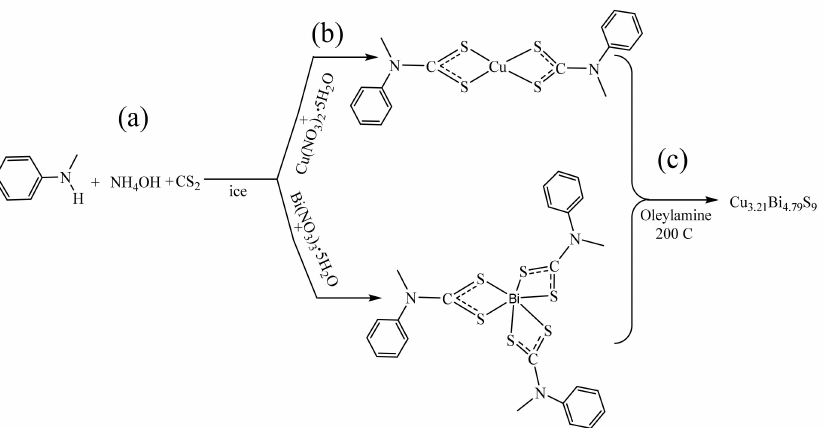
Scheme 1. Reaction process for the synthesis of ( a ) ligand, ( b ) complexes, and ( c ) copper bismuth sulphide (Cu 3.21 Bi 4.79 S 9 )